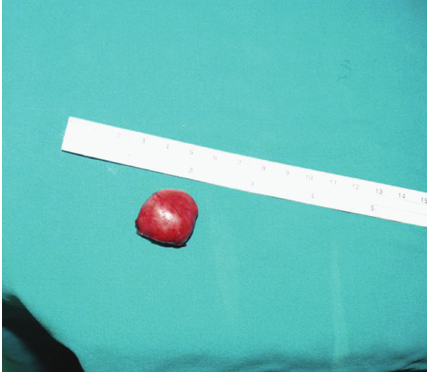
Figure 3: Buccal mucosa BFH: Surgical resection specimen.